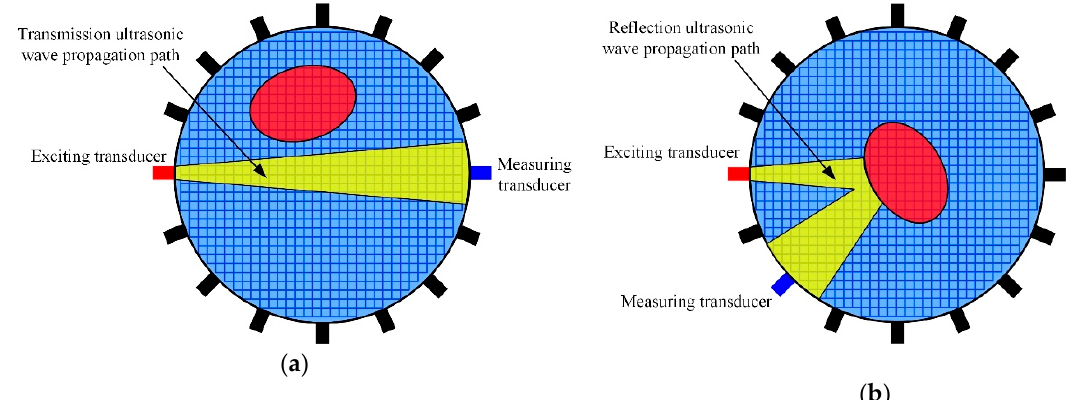
Figure 4. Schematic diagram of ultrasonic wave propagation path: ( a ) there is no target on the ultrasonic waves propagation path, ( b ) there is a target on the ultrasonic waves propagation path.